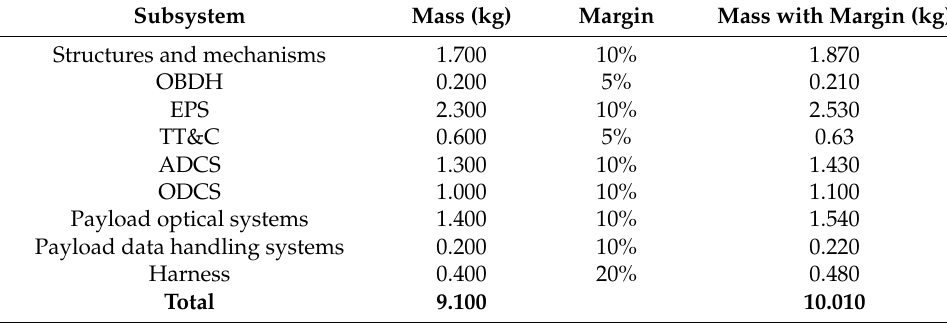
Table 10. HORUS nano-satellite indicative mass budget.